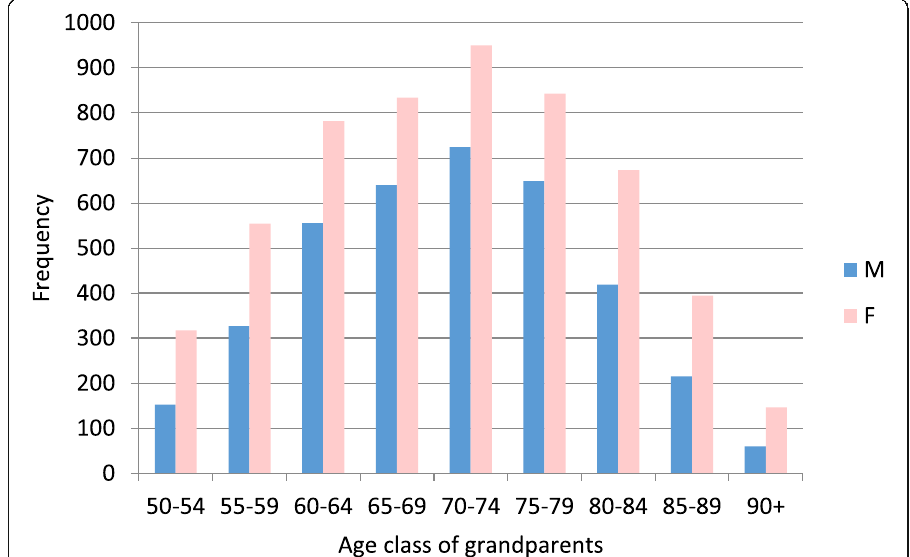
Fig. 1 Grandparental age distribution by gender (absolute values). Source: ISTAT Famiglie e Soggetti Sociali